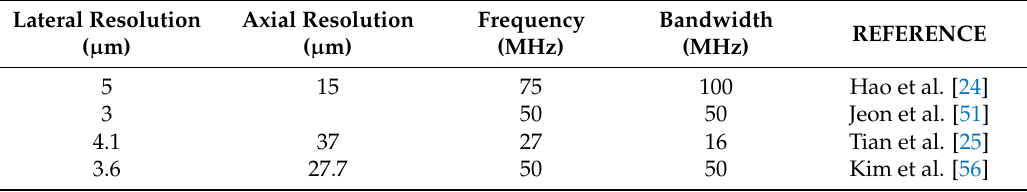
Table 2. Lateral and axial resolution of